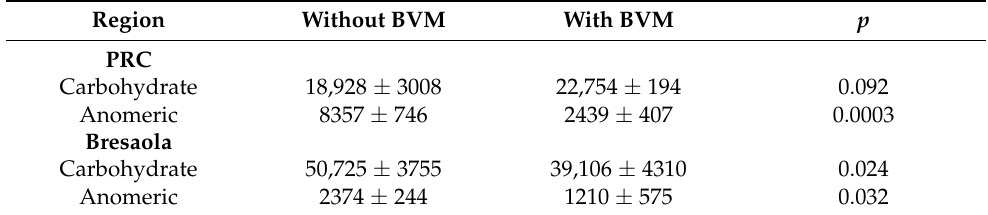
Table 2. Differential integral area ( ∆ 4D–1G) of carbohydrate and anomeric region of in vitro digested PRC, Bresaola, and boiled potatoes. All data are means ± SD of at least three independent in vitro digestions. Statistical analysis was by Student’s t